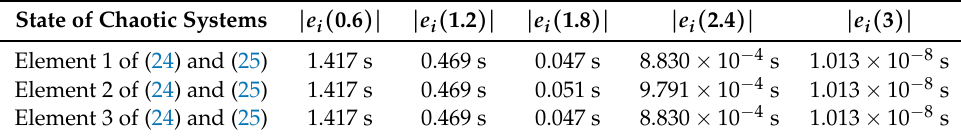
Table 1. Absolute values of errors between two identical Lu chaotic systems (24) and (25) equipped with controller (6) via the proposed SEZN approach at different time instants during the rejection of chaotic disturbances.